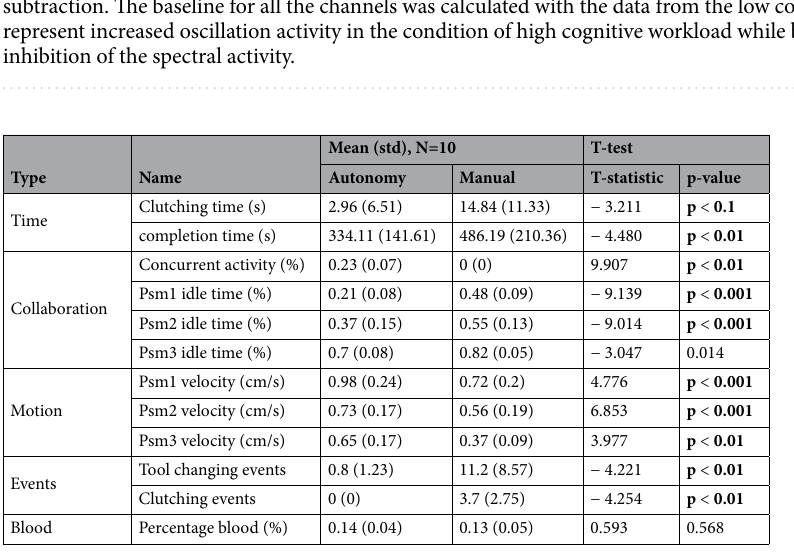
Table 2. Objective performance metrics results. Statistically significant results ( α = 0.05 ) were highlighted in